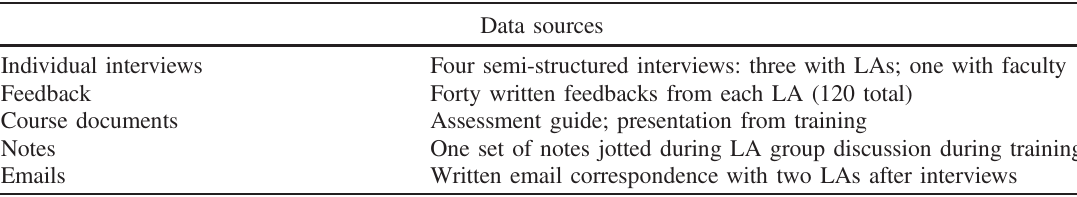
TABLE I. Five types of data sources: interviews, feedback, course documents, discussion notes, and